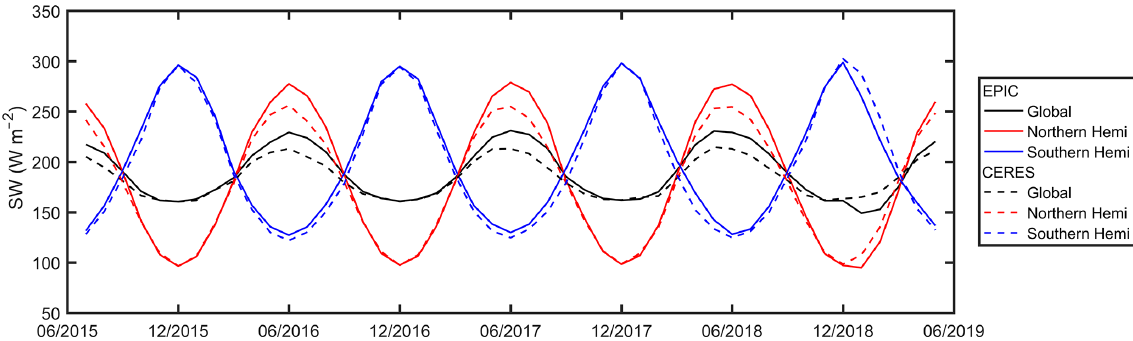
Figure 10. Temporal variations in EPIC- and CERES-based monthly total SW for the land surface of the globe, Northern Hemisphere and Southern